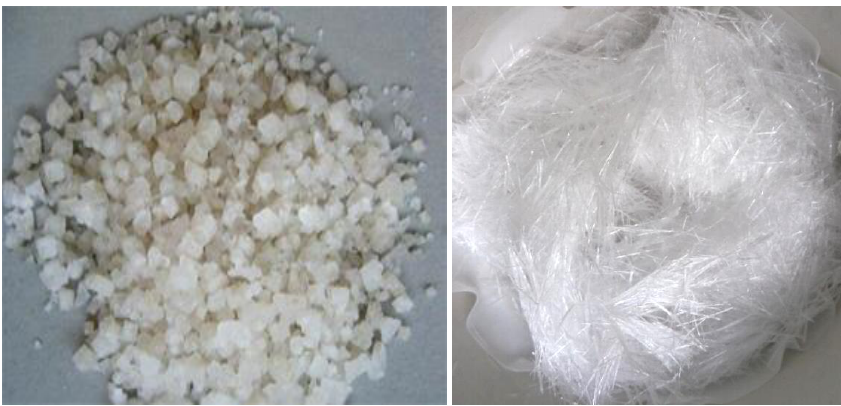
Figure 11. The digital images of MSM before and after electrodialysis.